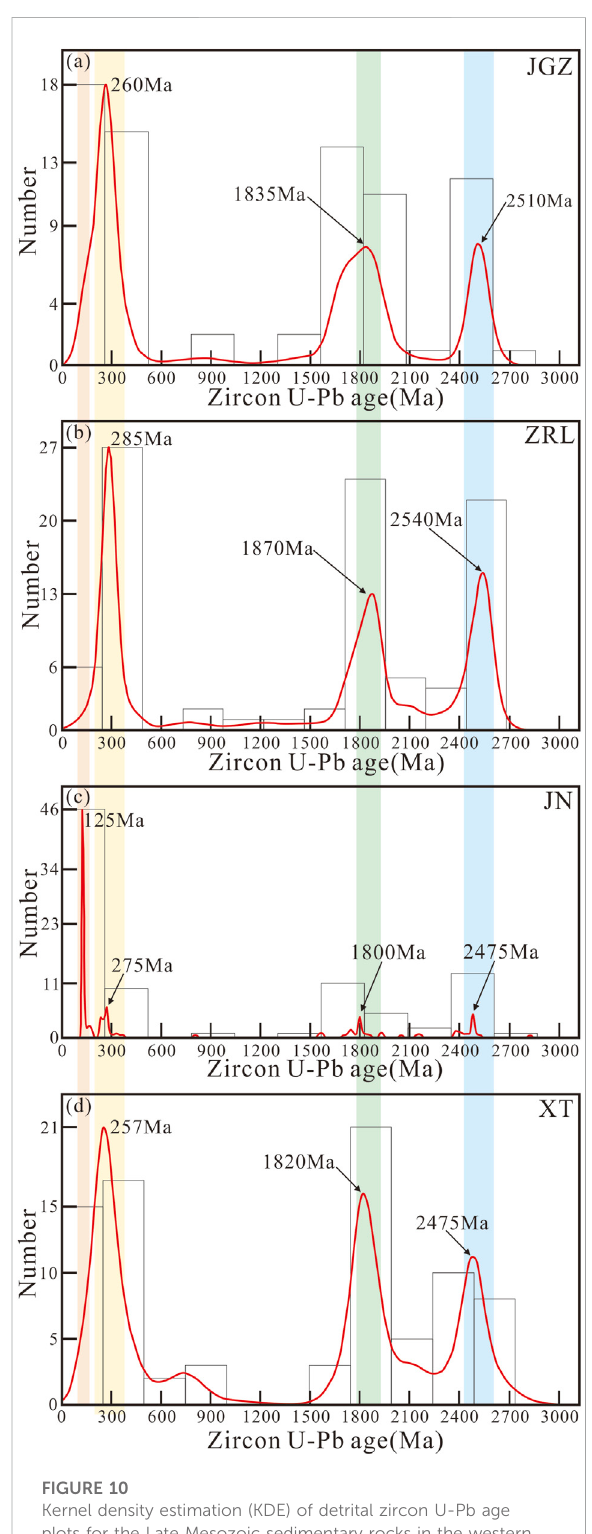
FIGURE 10 Kernel density estimation (KDE) of detrital zircon U-Pb age plots for the Late Mesozoic sedimentary rocks in the western Shandong province (A,B and D) and Tanlu fault zone (C) .